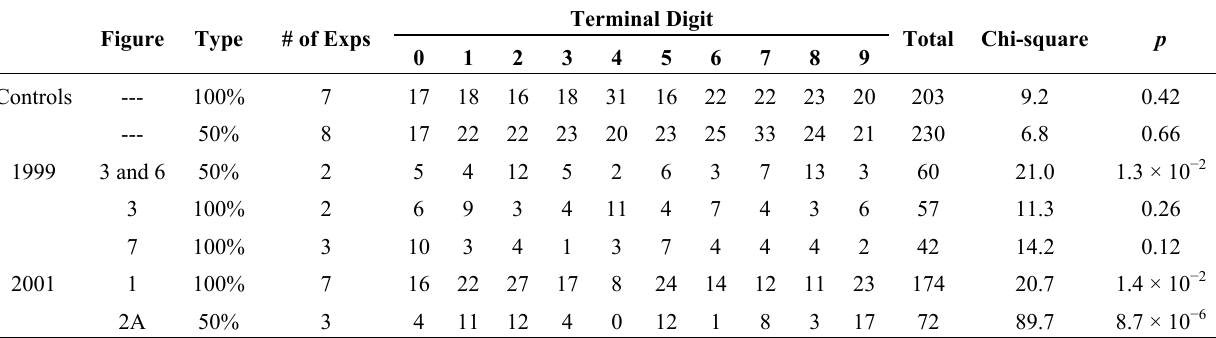
Table 1. Terminal digit analysis of coulter counts of experiments (Exps) represented in the published figures. The numbers of the various digit distributions were compared to the corresponding uniform distributions to calculate the chi-squared statistic and the corresponding probabilities for nine degrees of